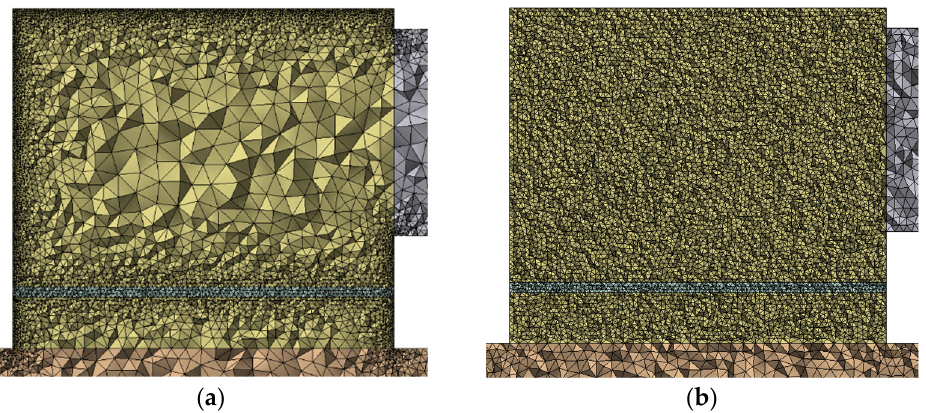
Figure 5. The computational mesh on the wall of the plenum box for ( a ) variant M4; ( b ) variant M6.